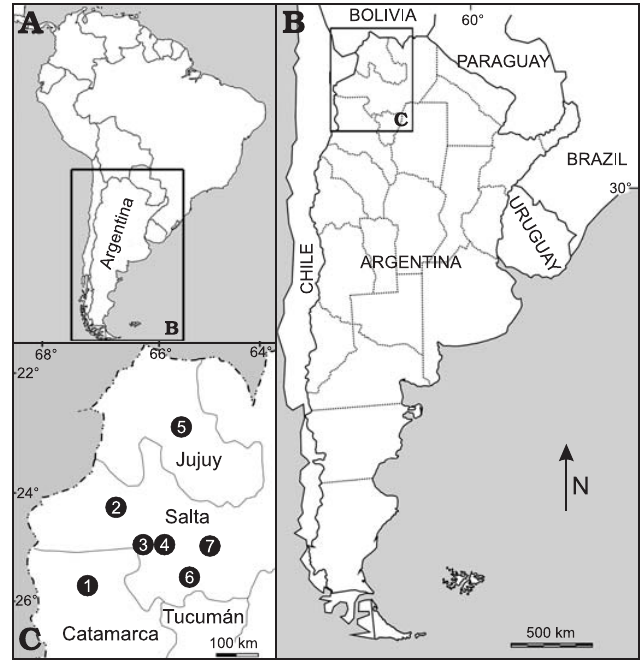
Fig. 1. A , B . Location of the studied area in South America. C . Map of Northwestern Argentina showing the main middle and middle–late Eocene fossil-bearing localities: 1, Antofagasta de la Sierra; 2, Quebrada El Paso; 3, Luracatao valley; 4, Cerro Tin Tin; 5, El Aguilar; 6, Estancia Pampa Grande—El Simbolar; 7, Juramento